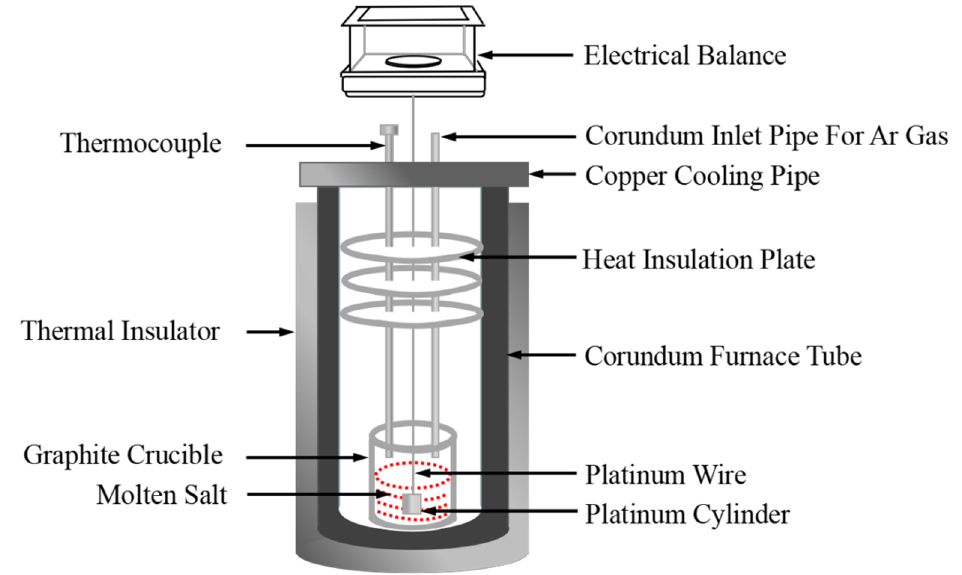
Figure 3. Schematic of the density measurement experimental setup. Thermal diffusivity ( α ) was measured by the laser flash analysis (LFA) technique,